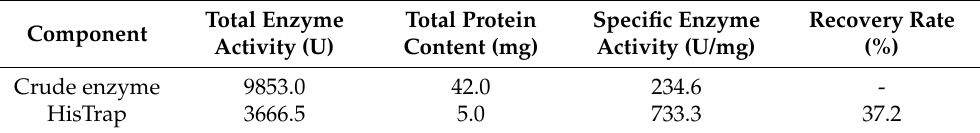
Figure 1. SDS-PAGE analysis of purified AMY. M: Molecular weight marker; 1: Crude enzyme; 2: Elution by 30% buffer B. Table 1. Purification of